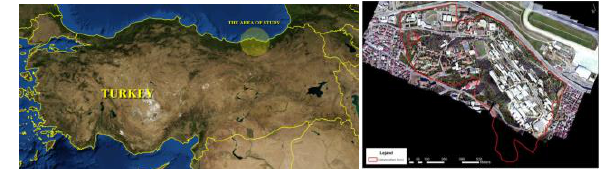
Figure 1. The borders of the study area.